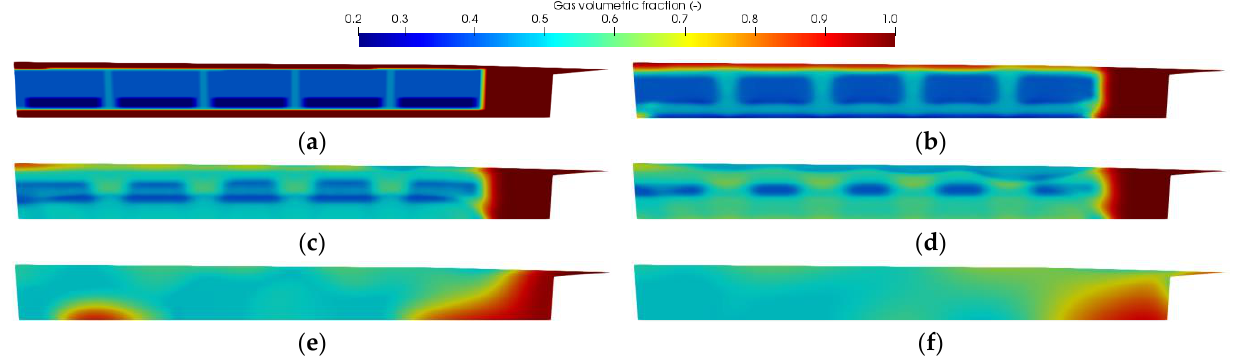
Figure 8. Numerical results for 155/39 five-module charge firing test. Gas volumetric fraction 𝛼 1 at different times: ( a ) 𝑡 = 0; ( b ) 𝑡 = 0.05 ms; ( c ) 𝑡 = 0.10 ms, ( d ) 𝑡 = 0.15 ms; ( e ) 𝑡 = 1.0 ms; ( f ) 𝑡 = 2.5 ms.